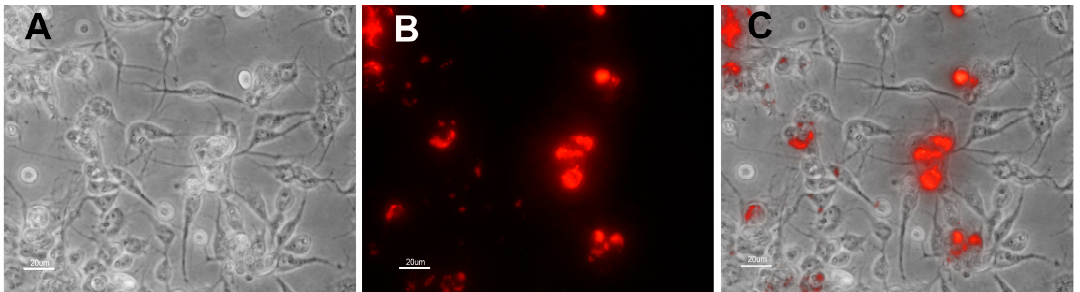
Figure 1. Images of Rickettsia buchneri ISO7 clone B8 transformed with shuttle vector pRAM18dRGA to express GFP uv . Transformants were isolated and grown in Ixodes ricinus embryonic cell line IRE11. Panel ( A ) Island of IRE11 cells containing transformed R. buchneri expressing GFP uv . Image collected 2.5 months after electroporation and rifampicin selection. Infected cells visualized using a fluorescein isothiocyanate (FITC) filter; Panel ( B ) Phase contrast microscopic appearance of IRE11 cells heavily infected with transformed R. buchneri. Transformed R. buchneri were in the 23rd serial transfer when imaged. Transformants were maintained in cell cultures at high density (1–5 × 10 6 cells/mL) and were diluted for this image. Infected cells detach; ( C ) Same field as shown in panel ( B ) but visualized using fluorescence microscopy with FITC filter; ( D ) Composite image made by merging images shown in Panels ( B , C ). All images taken with a Nikon Diaphot fluorescence microscope. Bar equals 40 µm in all panels.